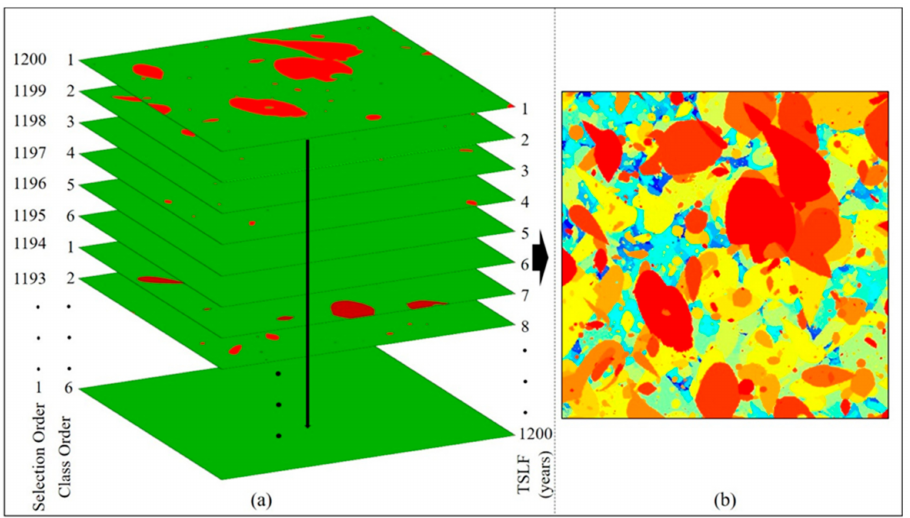
Figure 2. An example of ( a ) the stacking process of annual fire-year maps for the six classes of total annual area burned to create ( b ) a simulated time since last fire (TSLF) map. In the simulated TSLF map, warm colors represent area burned in recent years, while cold colors show areas burned longer